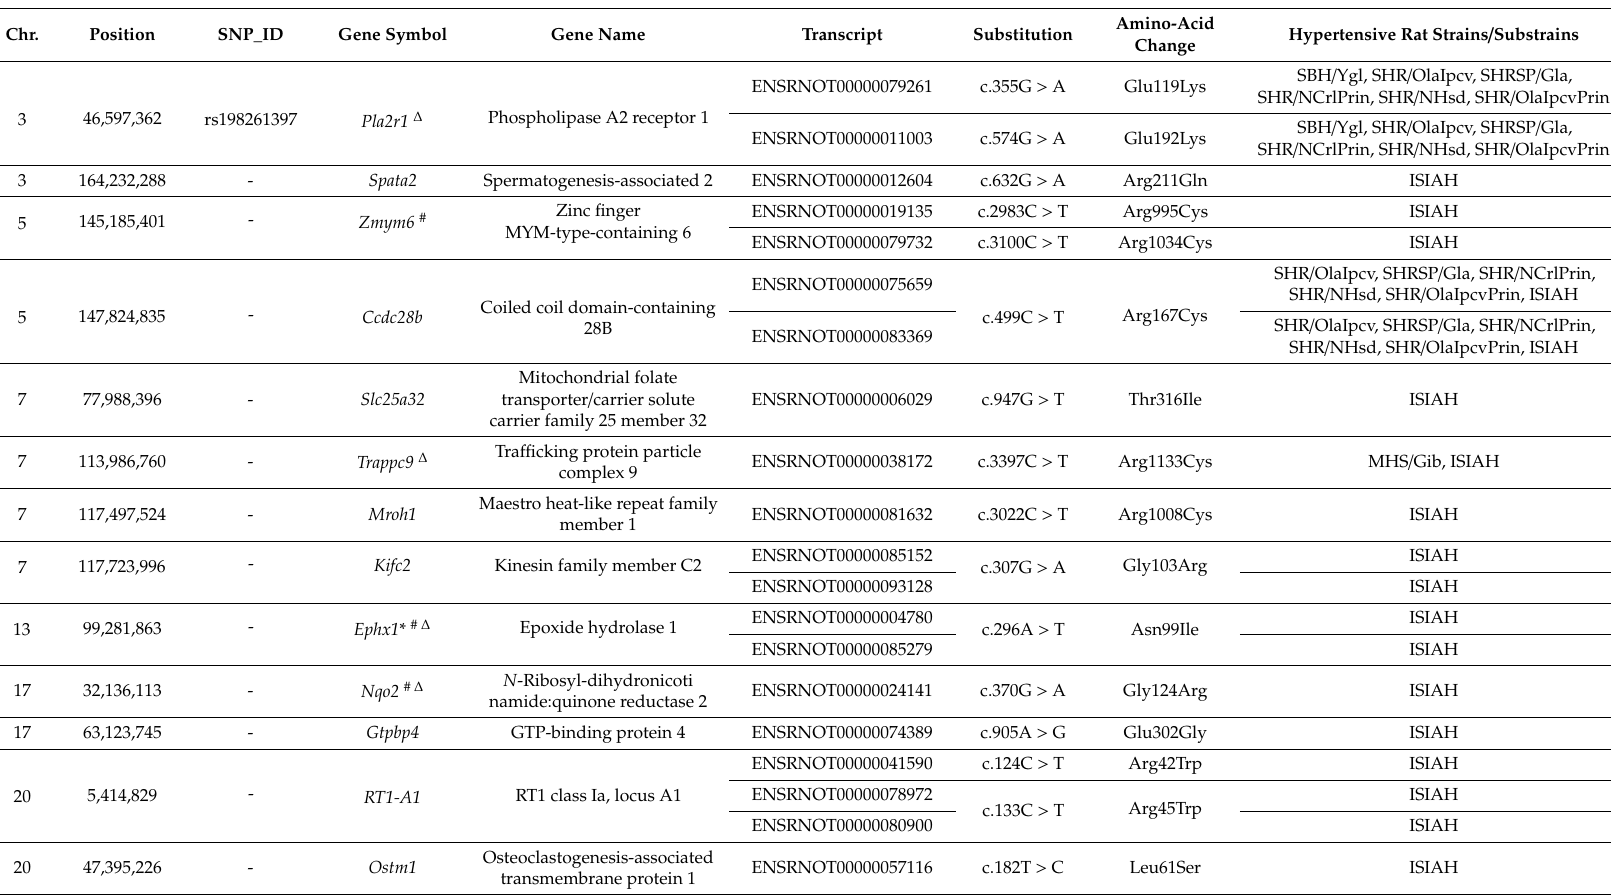
Table 4. Mutations that presumably have a significant influence on the structure and / or function of the respective protein according to the SIFT algorithm and may be related to the development of the hypertensive state in OXYS rats.